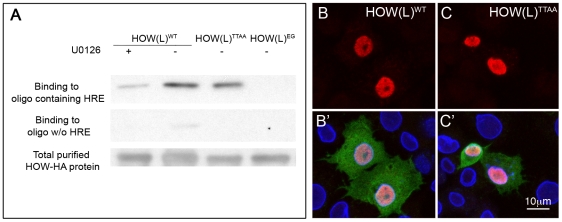
HOW phosphorylation strengthens its affinity to RNA, while not affecting its subcellular localization.A. In vitro RNA-protein binding assay. HA tagged HOW(L)WT, HOW(L)TTAA or HOW(L)EG constructs were purified from S2R+ cells by immunoprecipitation of the HA tag, followed by elution with free HA peptide. HOW(L)WT transfected cells were either treated with U0126 or not treated. Equal volumes of purified proteins were incubated with biotin labeled 12 nt oligomers that either bind HOW (top panel) or do not bind HOW (middle panel). The complexes were incubated with avidin beads, eluted by boiling in sample buffer and reacted with anti HOW in a Western blot. The amounts of HOW protein used for each reaction were comparable (bottom panel). B–C′. Localization of HOW(L) was not altered due to the mutations in the Thr residues. Cells expressing either HOW(L)WT (B,B′) or HOW(L)TTAA (C,C′) were stained for HOW (red, B–C). Merge images (B′–C′) also present GFP (green, marks transfected cells) and Lamin (blue).